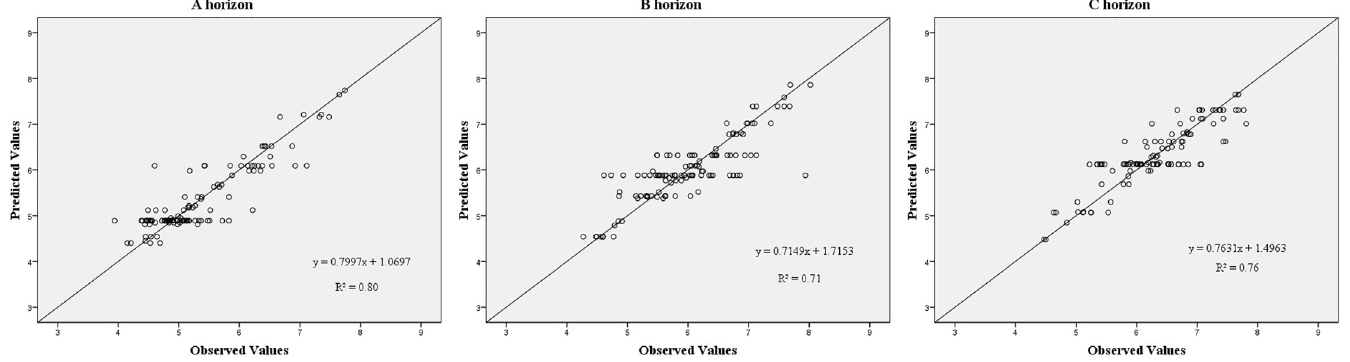
Fig 3. Scatter plots of observed and predicted soil pH based on CARTs for each horizon: a) A horizon, b) B horizon, and c) C horizon.